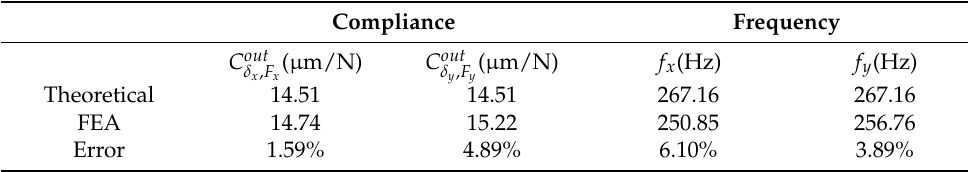
Table 2. Comparisons between FEA and the theoretical